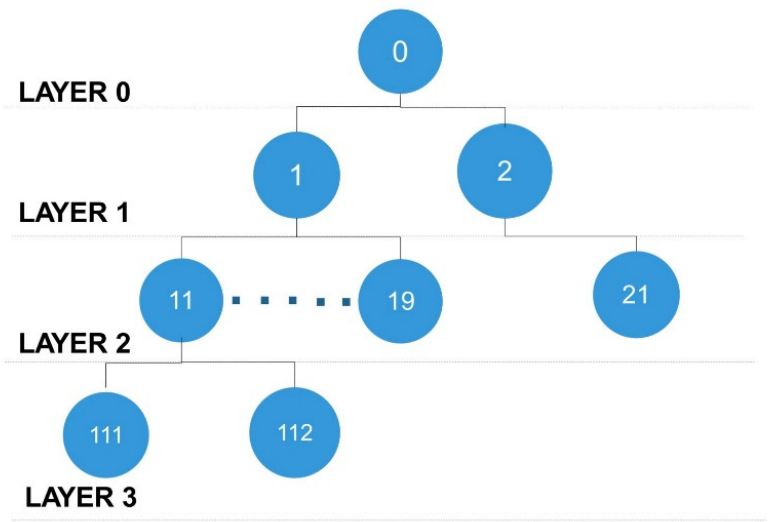
Figure 8. Layered based network architecture